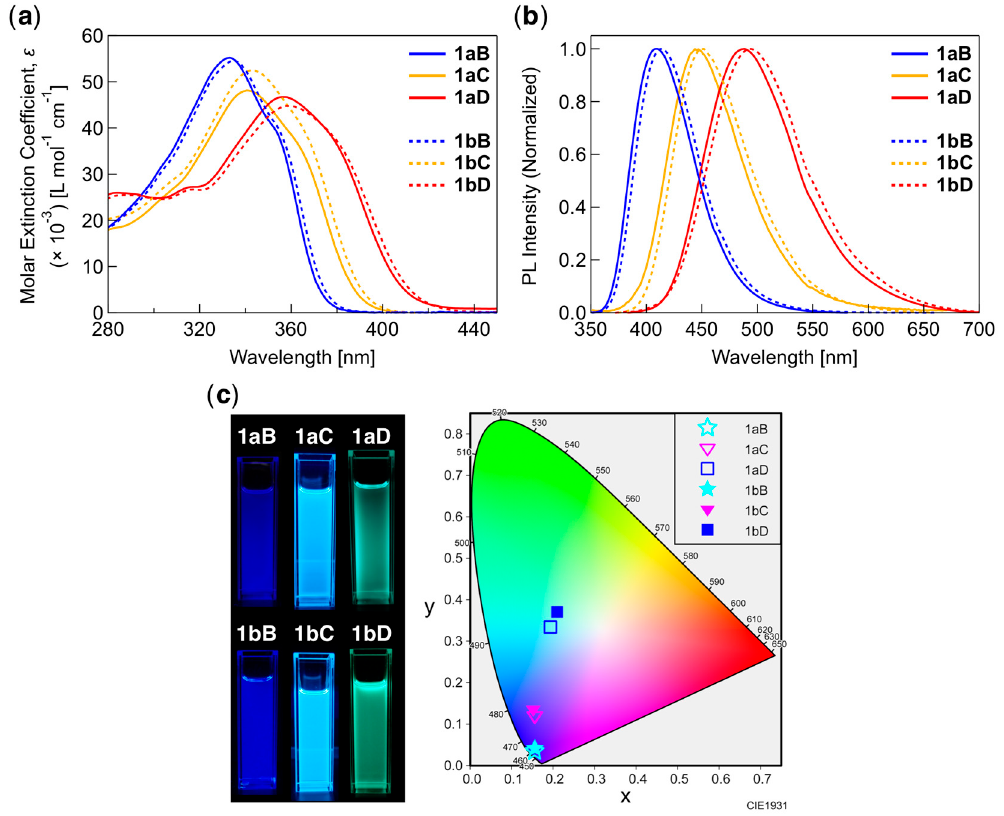
Figure 5. ( a ) Absorption spectra of 1aB – D (solid lines) and 1bB – D (dashed lines) in CH 2 Cl 2 (1.0 × 10 − 5 mol L − 1 ); ( b ) photoluminescence (PL) spectra of 1aB – D (solid lines) and 1bB – D (dashed lines) in CH 2 Cl 2 (1.0 × 10 − 6 mol L − 1 ); ( c ) photographs under ultraviolet (UV) irradiation ( λ ex = 365 nm) and CIE